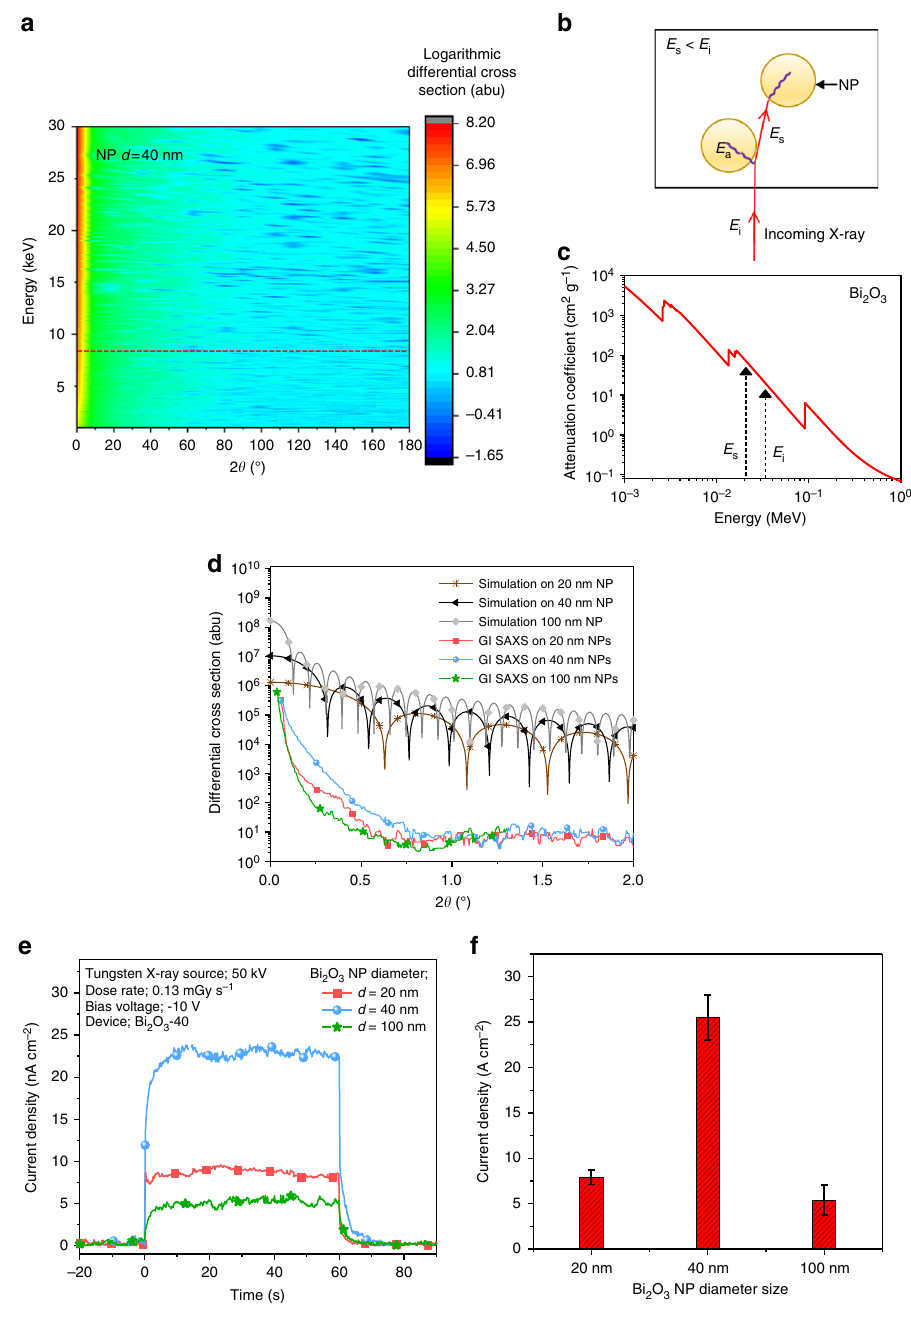
Fig. 6 X ray scattering by nanoparticles. a Simulated differential cross sections for X-ray scattering from Bi 2 O 3 NPs with a diameter ( d ) of 40 nm. b The schematic of the inelastic Mie-scattering mechanism and c the mass attenuation coef fi cient curve of Bi 2 O 3 . Here, E i , E a and E s are the energy of the incident X-ray photon, energy absorbed and the energy of the scattered photon, respectively. d The comparison of simulated differential cross section and extracted 1D data of experimental grazing incidence small angle X-ray scattering (GI-SAXS) at 8 keV energy for fi lms with d = 20, 40 and 100 nm NPs. (The dotted line in a represents the extracted data at 8 keV.) e X-ray photocurrent response of the polymer diodes containing Bi 2 O 3 NP sizes of 20, 40 and 100 nm and f the current density value with the spread for six